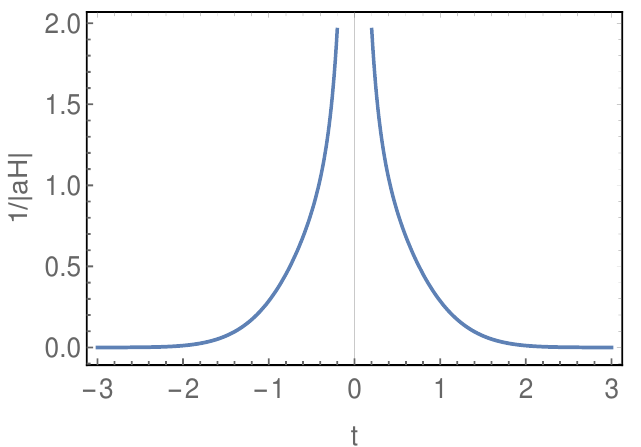
Figure 2. r h ( t ) vs. t for t s = 0. The parameter values are considered to be the same as those in the earlier figure. In this case, t s = t b